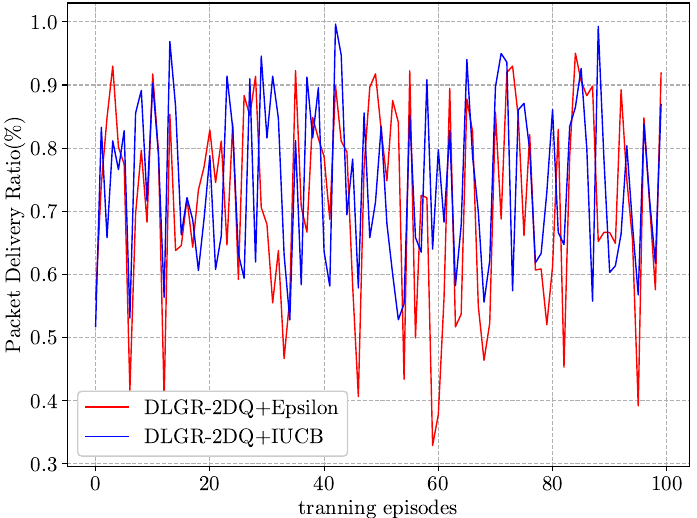
Figure 6. Convergence performance comparison of different exploration strategies during the training